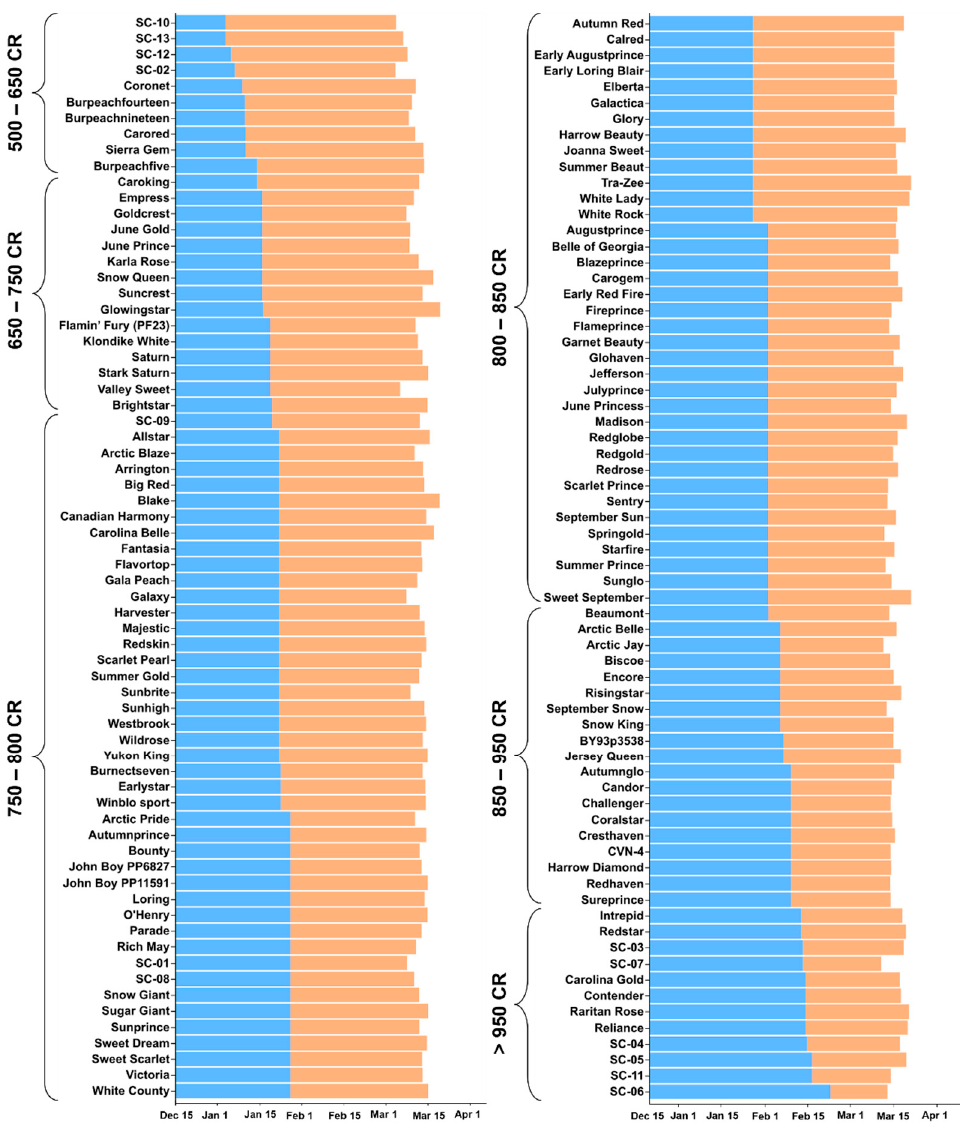
Figure 2. Chilling (Blue; from 1 November) and heat requirement (Orange; from the day of chilling fulfillment until 90% of full bloom) intervals observed in the U.S. peach germplasm. Ranges of chilling requirements (CR) are indicated on the left. Heat requirement (HR) is expressed in growing degree hours (GDH) calculated using standard base temperature of 4.5 °C. Data represent the best linear unbiased prediction (BLUP) values for CR and HR across eight years (2014–2021).